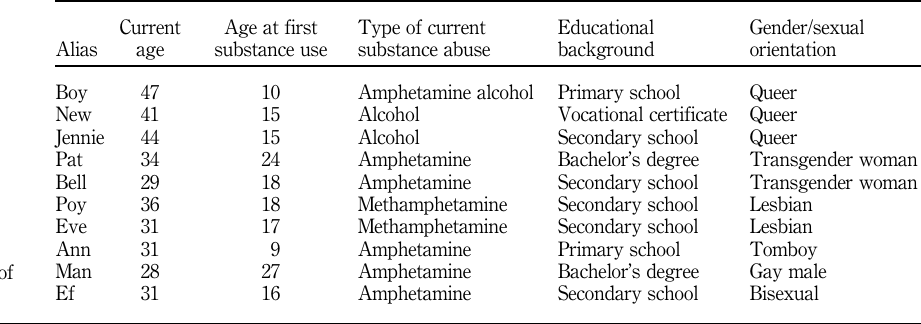
Table I. Personal profiles of the